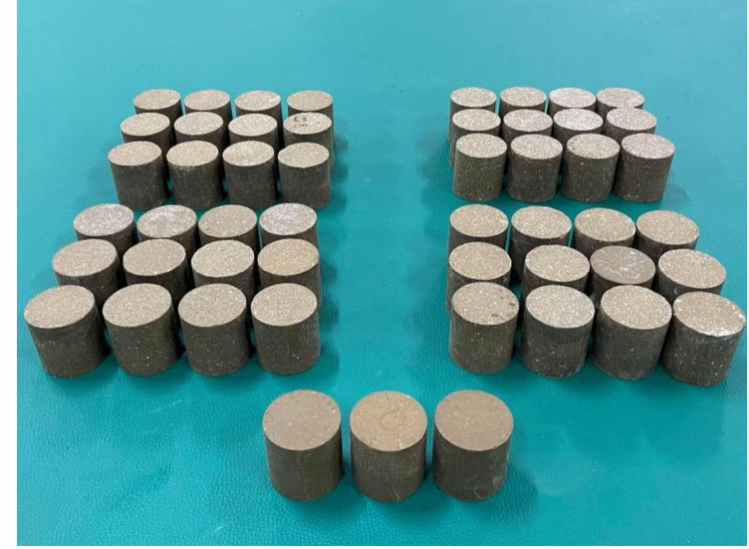
Figure 1. A set of prepared